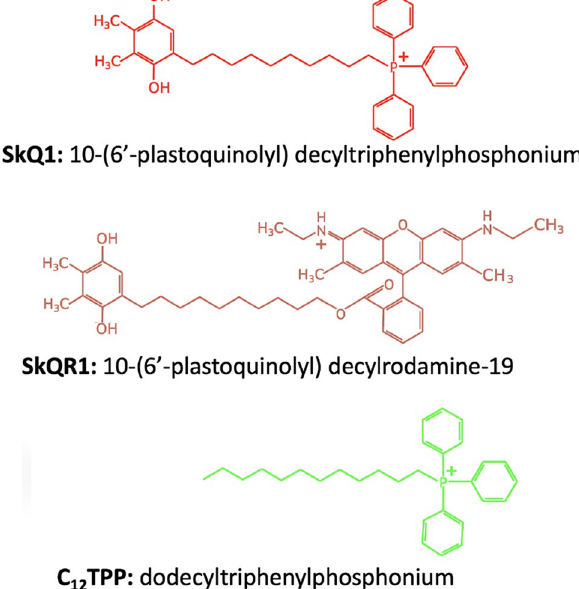
Figure 1. Chemical structure of mitochondria-targeted